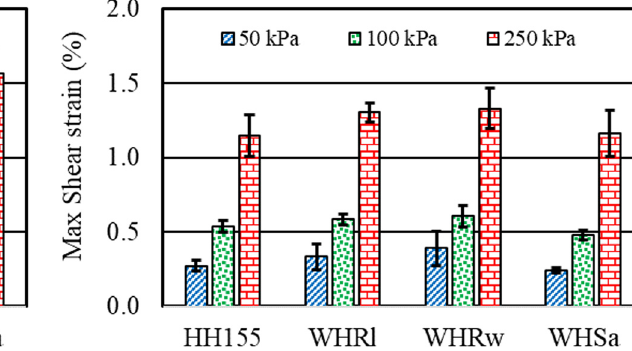
Figure 8: Maximum shear strain at each testing cycle of WMAs manufactured at